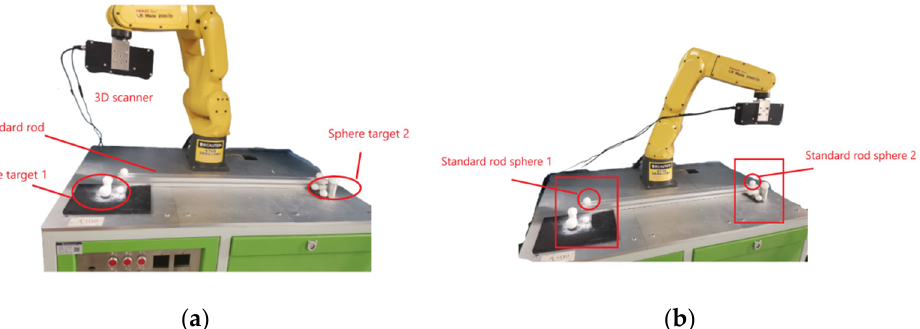
Figure 8. Coordinate unification experiment diagram: ( a ) measurement of target 1 and standard rod sphere 1; ( b ) measurement of target 2 and standard rod sphere 2. Table 5. Target ball center values for articulated arm calibration. Group